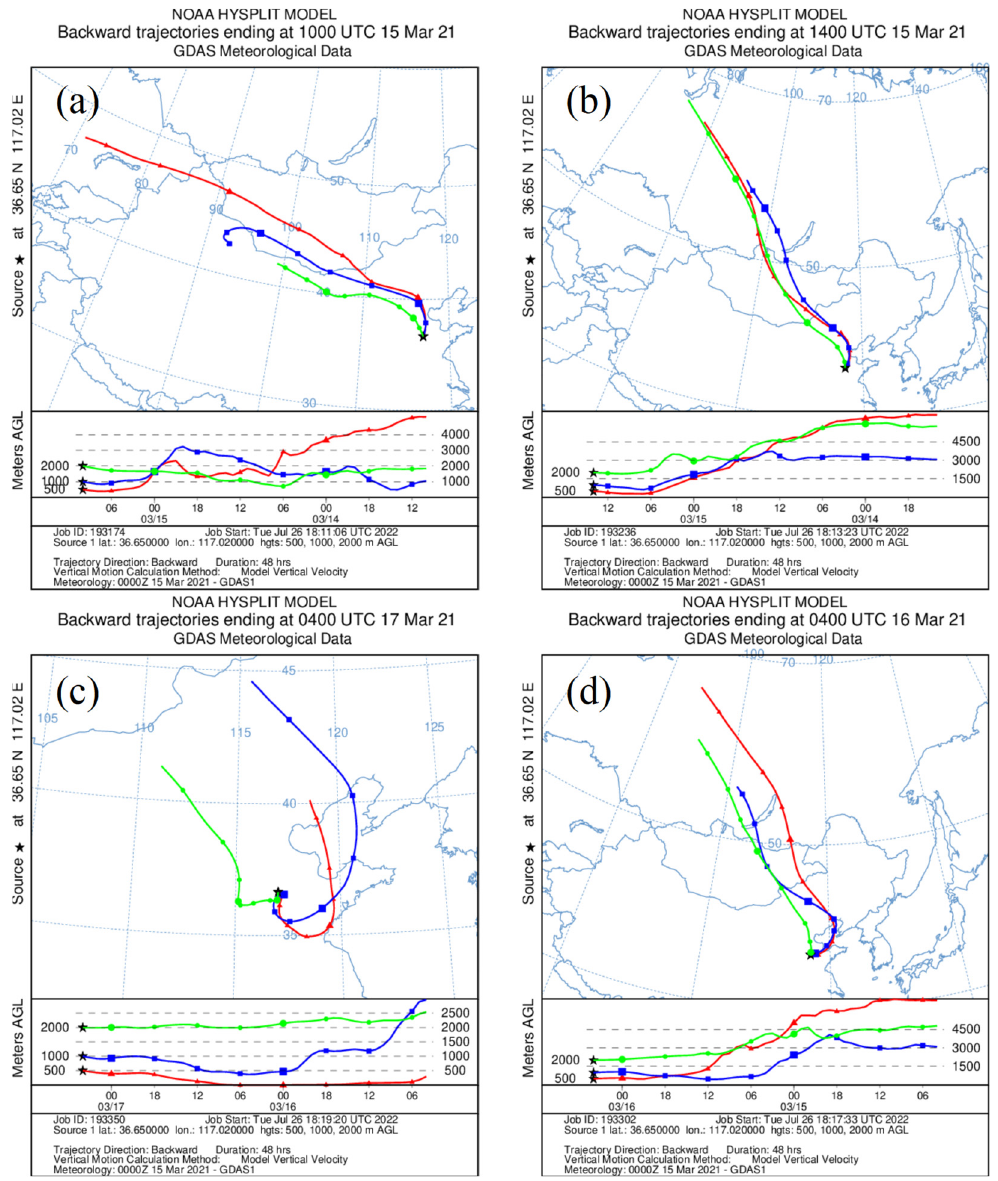
Figure 7. The map of 48 h backward trajectories, the ( a – d ) sub-graphs represent the trajectories with the start time at 18:00 of 15 March, 22:00 of 15 March, 12:00 of 16 March and 12:00 of 17 March, respectively.